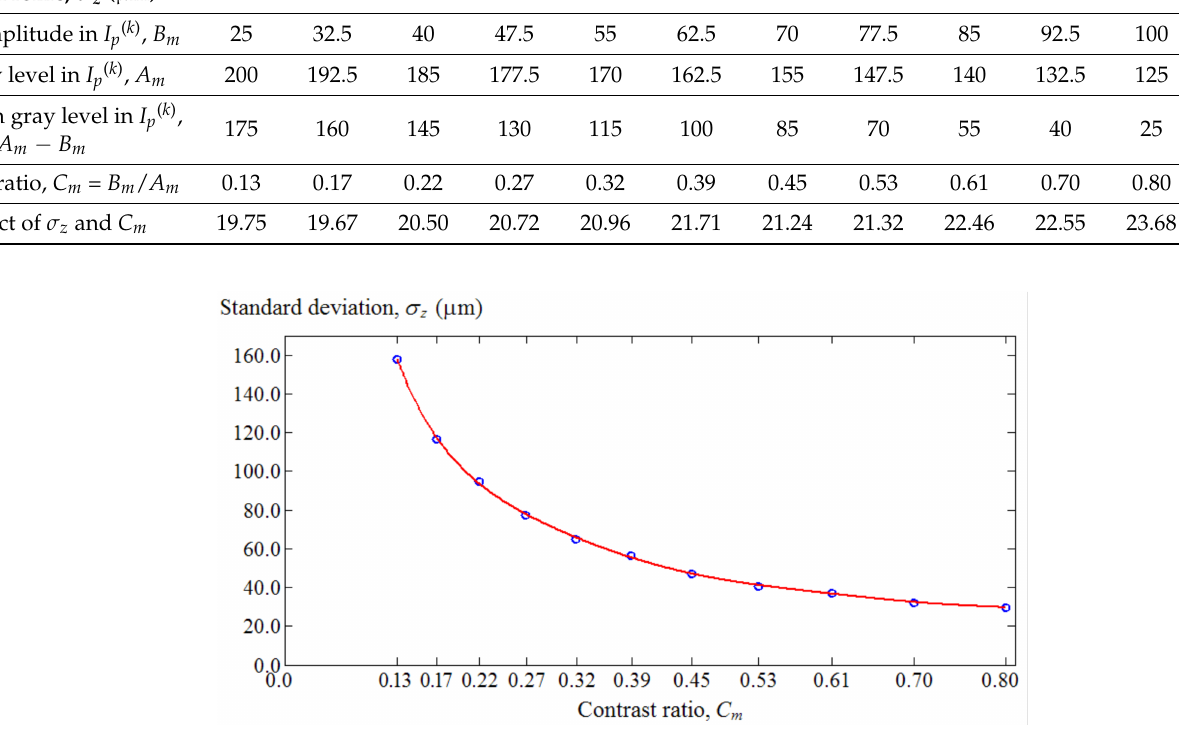
Table 1. A list of standard deviations with corresponding fringe amplitudes, DC gray levels, and minimum gray levels. Standard Deviation of the Depth Profile, σ z ( µ m)